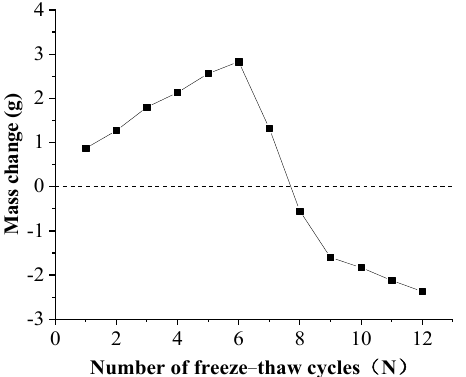
Figure 5. Effect of freeze − thaw cycles on the mass of specimens.